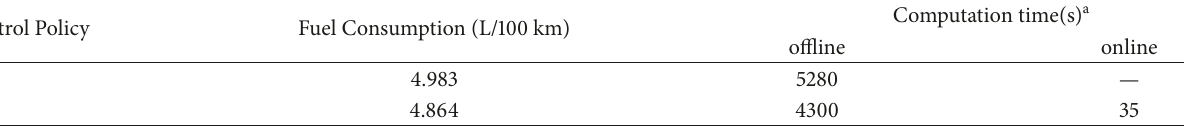
Table 3: Simulation results based on CYC